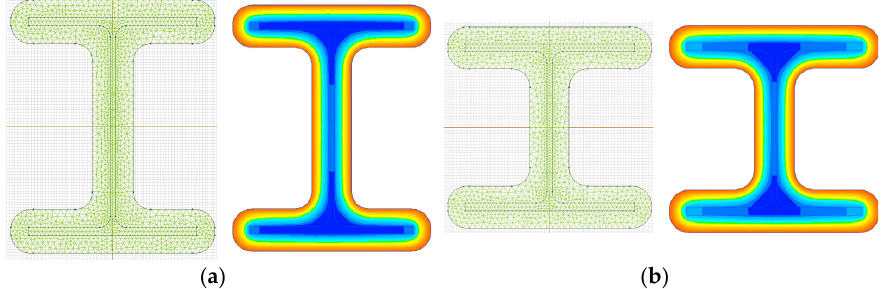
Figure 5. Scheme of samples with coatings No. 1.1–No. 1.3 and visualization of heating of